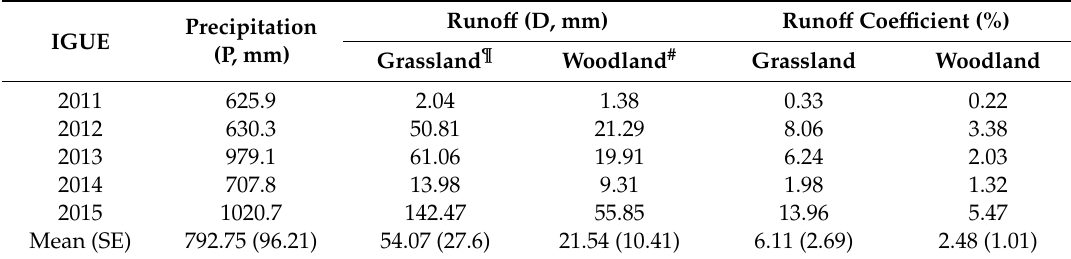
Table 1. Annual runoff response to precipitation for grassland watershed and redcedar woodland watershed. Runoff increases linearly with precipitation in grassland watershed.